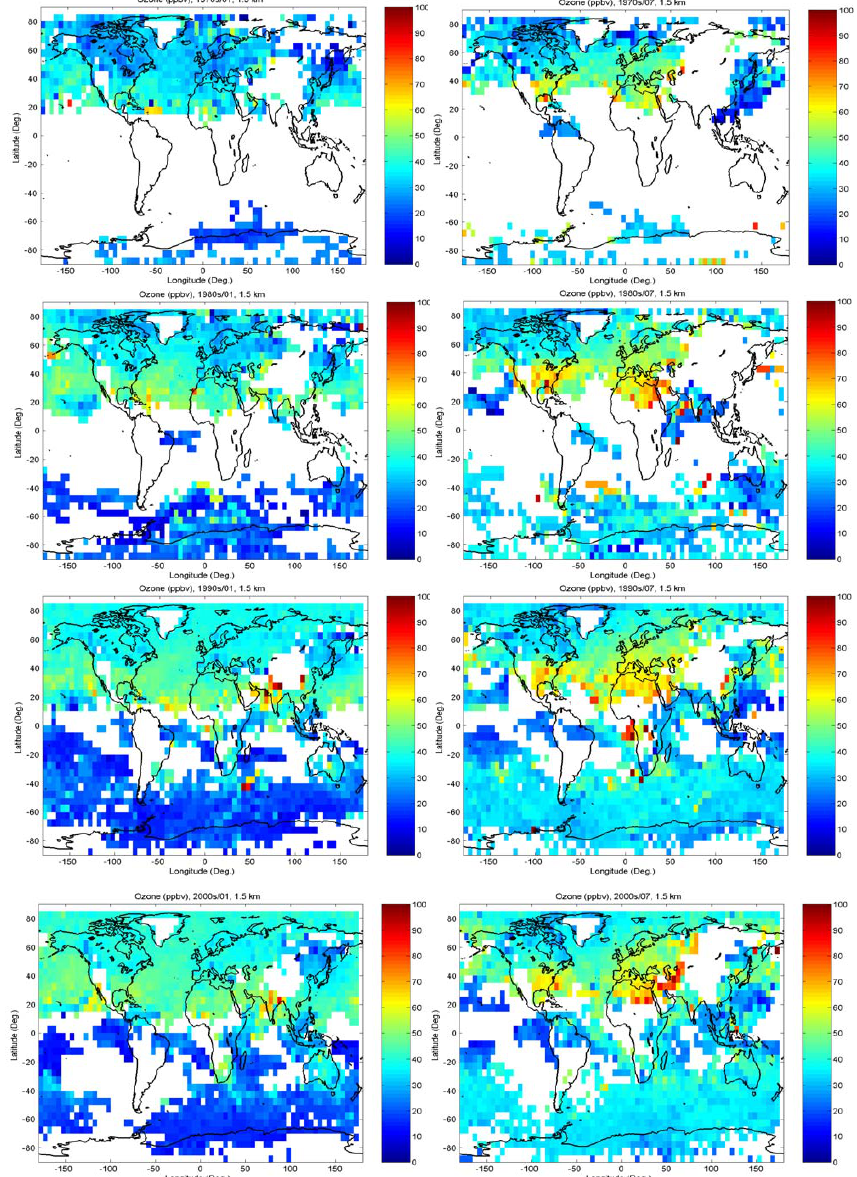
Fig. 9. Unsmoothed (5 ◦ × 5 ◦ pixel averaged) maps at 1–2km for January (01) and July (07) for each decade since